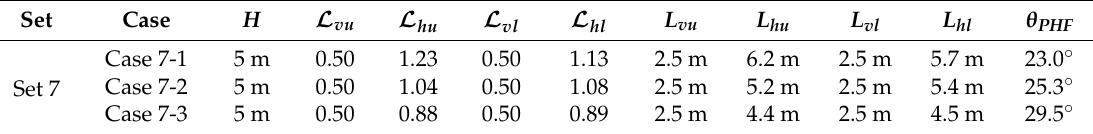
Figure 7. Evaluated PHF trajectories in Set 7 in Table 11 (the legends in ( a – c ) show the σ 3 distributions): ( a ) Evaluated PHF trajectory in Case 7-1; ( b ) Evaluated PHF trajectory in Case 7-2; ( c ) Evaluated PHF trajectory in Case 7-3. Table 12. Field scale PHF behaviors in Set 7 evaluated from laboratory scale numerical